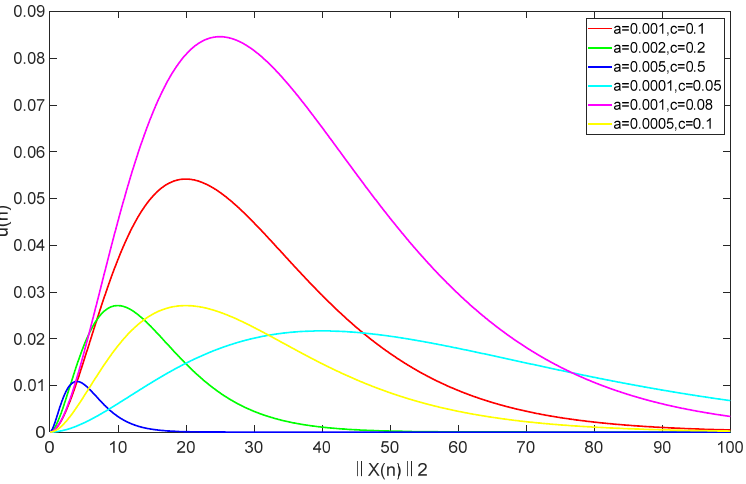
Figure 3. Step function